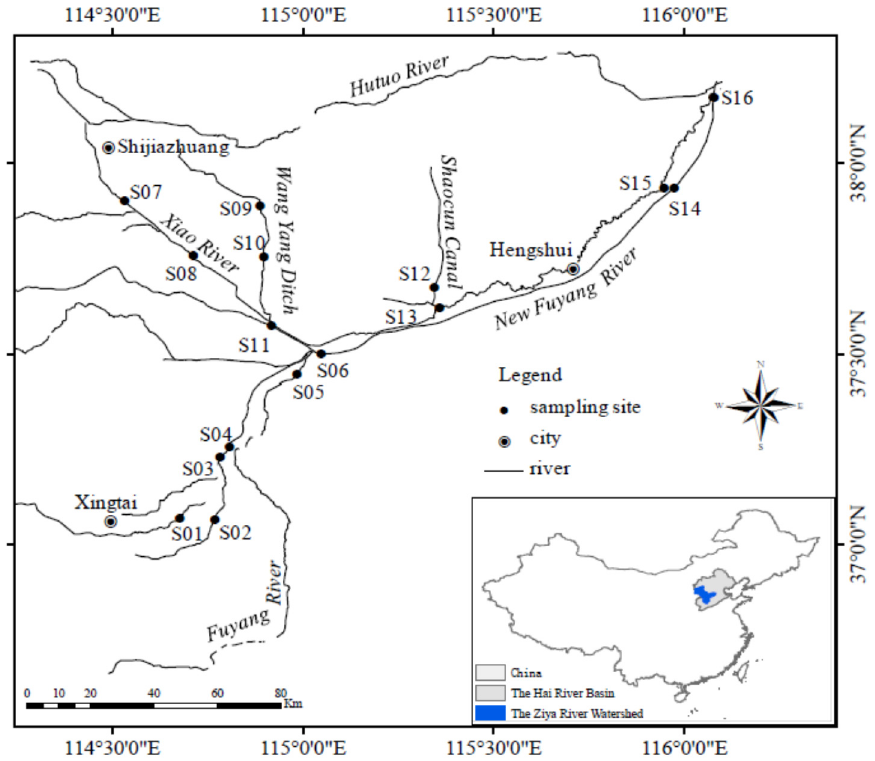
Figure 1. Location of the study sites in the Ziya River Watershed, China.